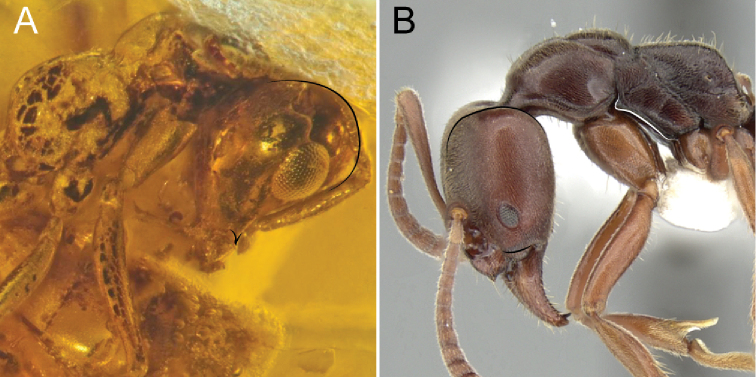
Cranial and mesosomal profiles of Antennoclypeata A †Brownimecia
clavata holotype worker, lateral (AMNH-NJ667, AntWeb: Dave Grimaldi and Vincent Perrichot) BAustroponera
castanea (Mayr, 1865) worker, lateral (CASENT0249168, AntWeb: Ryan Perry).